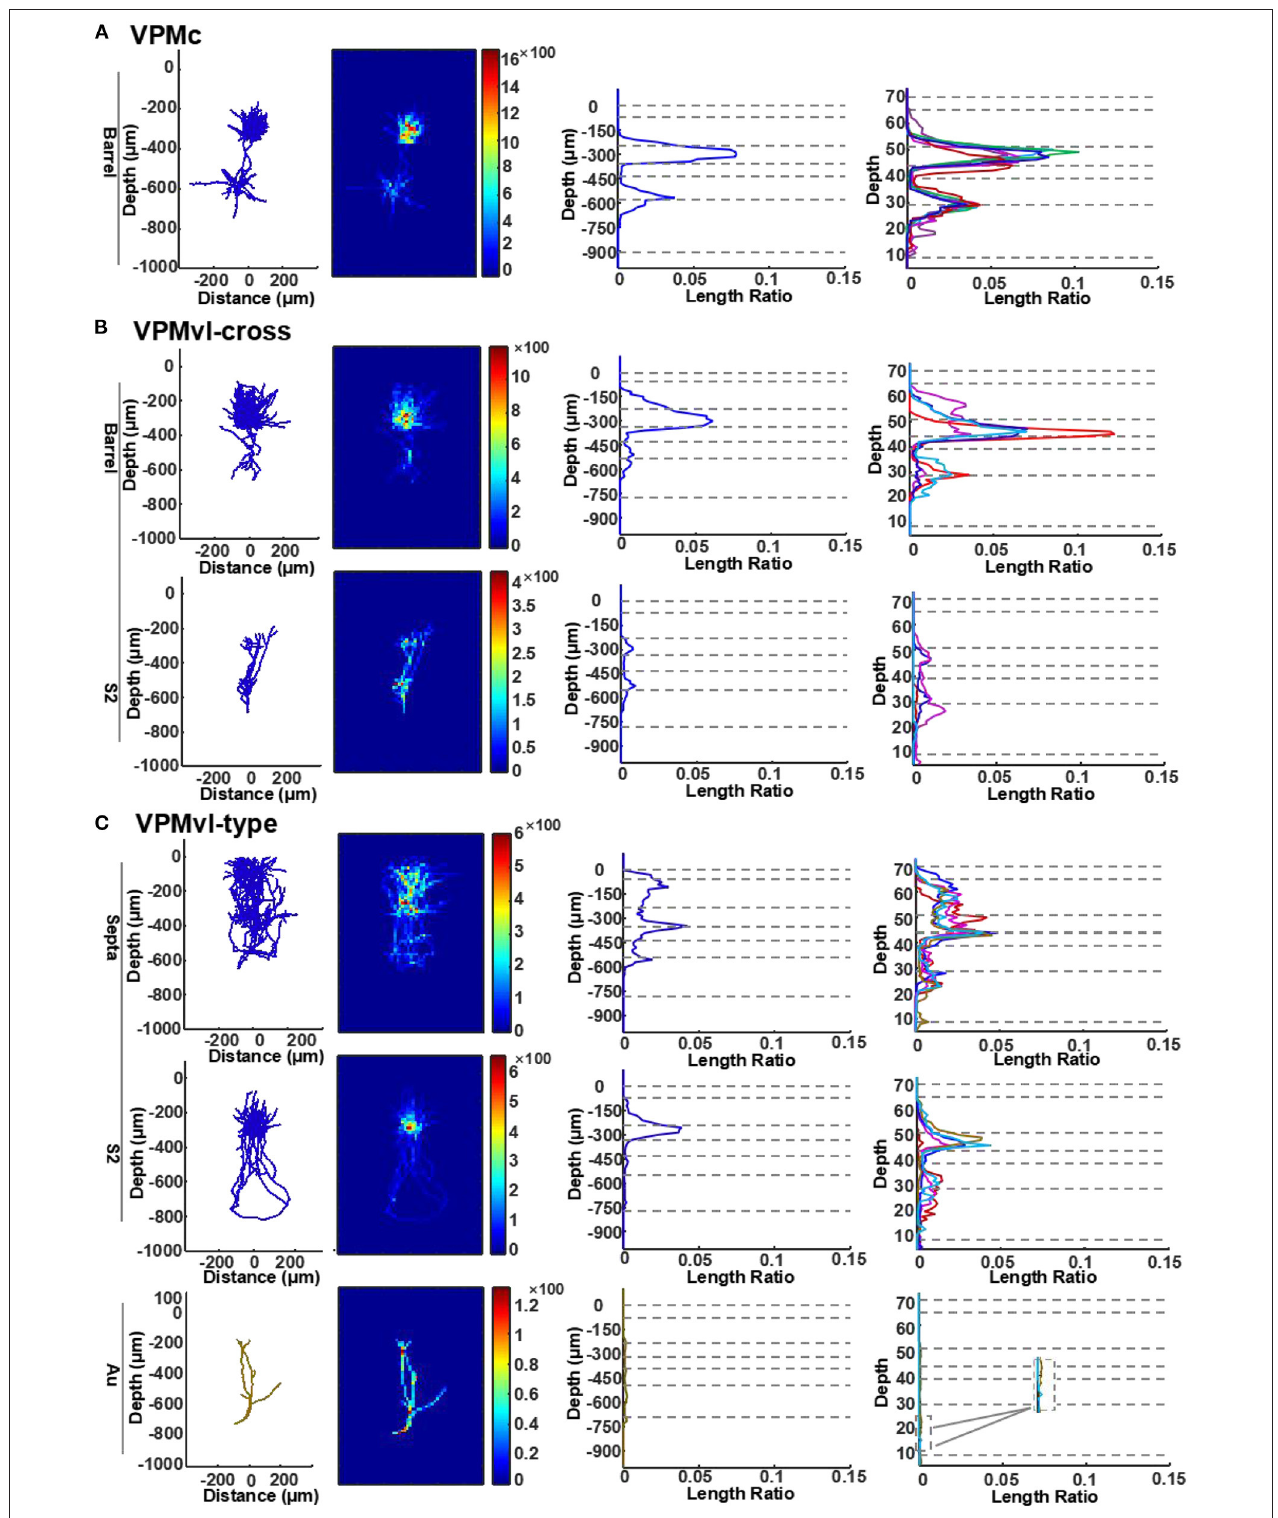
FIGURE 6 | Quantitative analysis of VPM axons in different layers of the cortex. (A) Length density analysis of thalamocortical axons in different layers of VPMc neurons. For typical VPMc neurons, the row is for axons in barrel columns. The first column: projection of reconstructions (axons in blue). The second